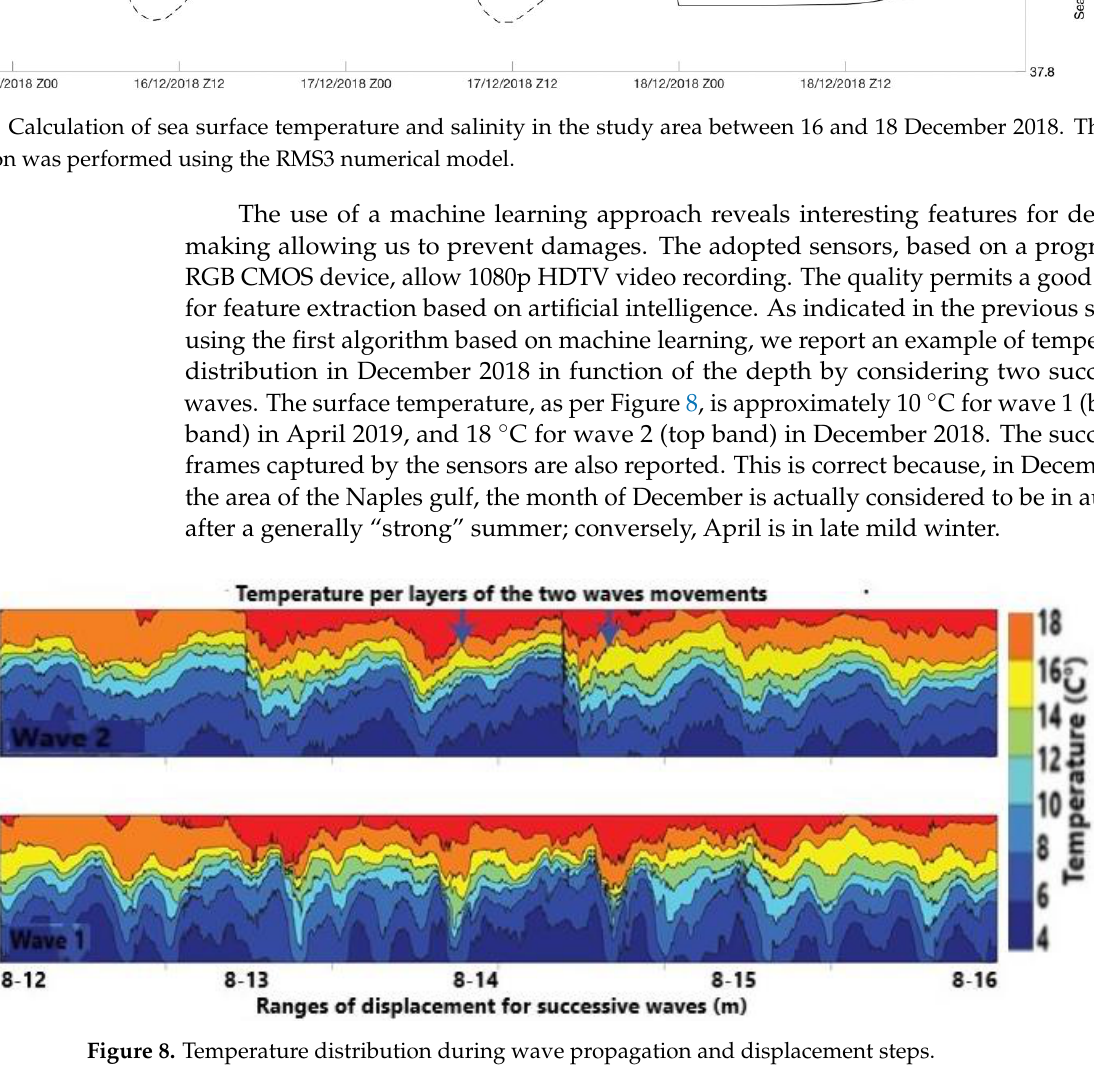
Figure 9. Vertical speed profile in theoretical and training steps.